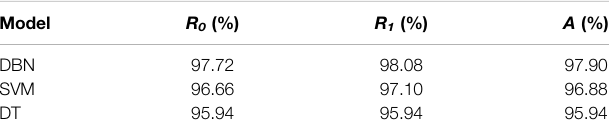
TABLE 1 | Accuracy of different models.